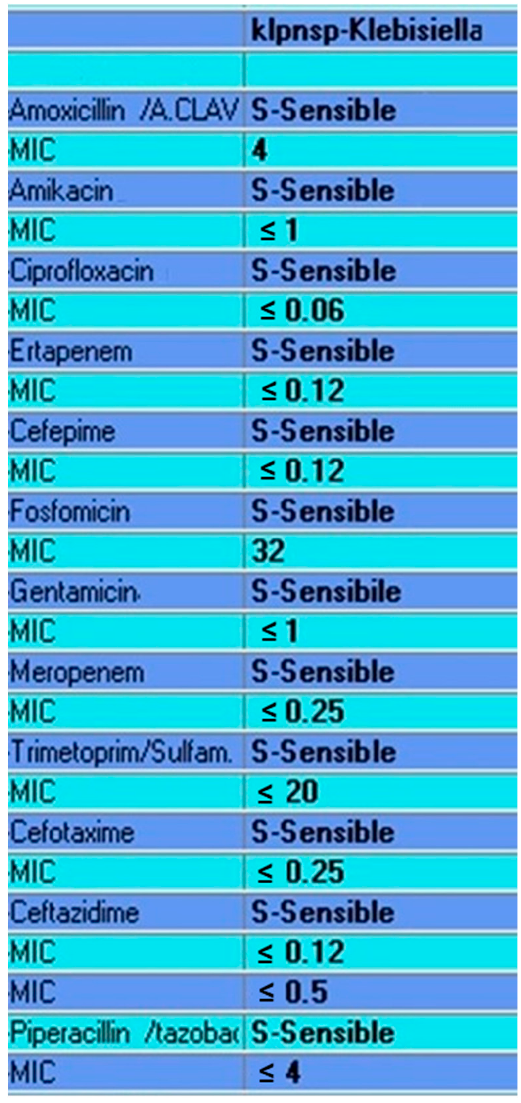
Figure 5. Klebsiella Pneumoniae antimicrobial susceptibility test results.